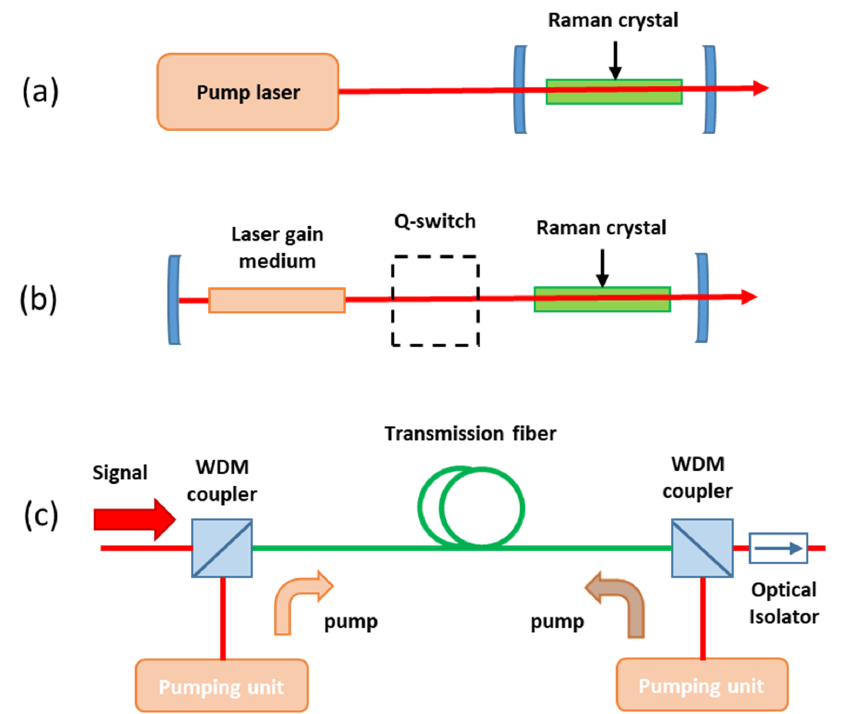
Figure 2. Typical configurations of the Raman laser: ( a ) external-resonator Raman laser; ( b ) intracavity Raman laser; and ( c ) fiber Raman amplifiers.